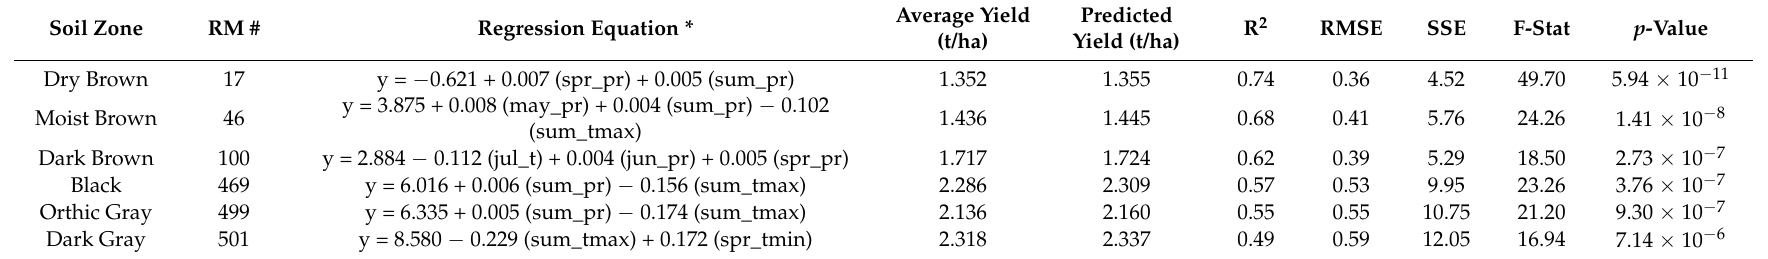
Table 3. RM-based regression equation statistics for selected RMs (one per soil